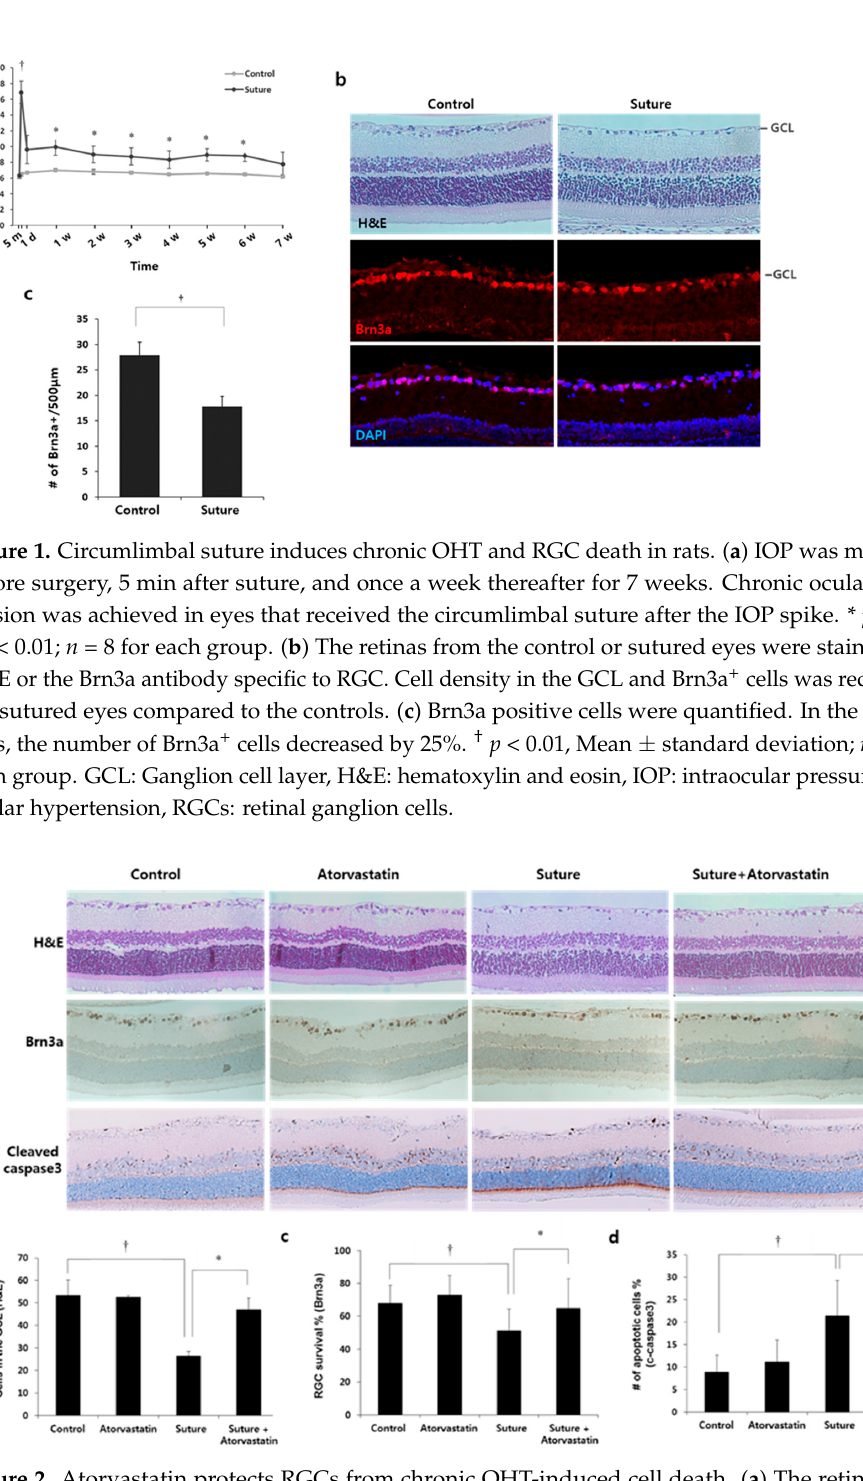
Figure 2. Atorvastatin protects RGCs from chronic OHT-induced cell death. ( a ) The retinas were either stained with H&E or processed by immunohistochemistry for Brn3a or cleaved caspase-3. The number of cells ( b ), number of Brn3a + cells ( c ), and cleaved caspase-3 + cells ( d ) in the GCL were quantified. Atorvastatin injection protected RGCs from chronic OHT-induced injury. GCL: Ganglion cell layer, IPL: inner plexiform layer, INL: inner nuclear layer, OPL: outer plexiform layer, ONL: outer nuclear layer, H&E: hematoxylin and eosin, OHT: ocular hypertension, RGCs: retinal ganglion cells; * p < 0.05, † p < 0.01; n = 5 for each